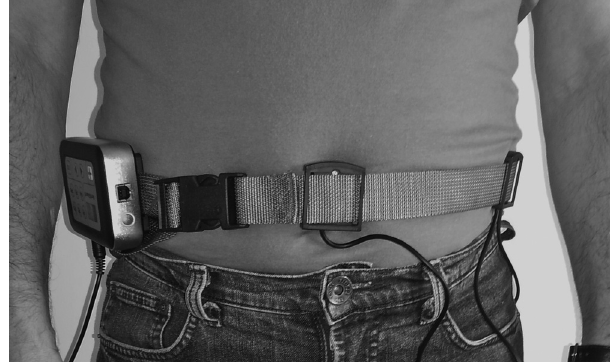
Figure 1 Vertiguard TM coupled to the patient’s waist.